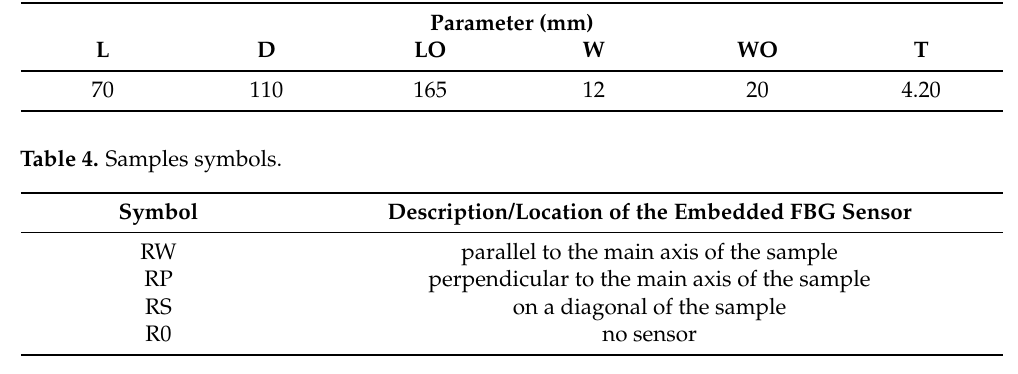
Figure 2. Schema of samples: ( a ) RW, ( b ) RP, ( c ) RS, and ( d ) R0. Symbols according to Table 4. Table 3. Samples dimensions.